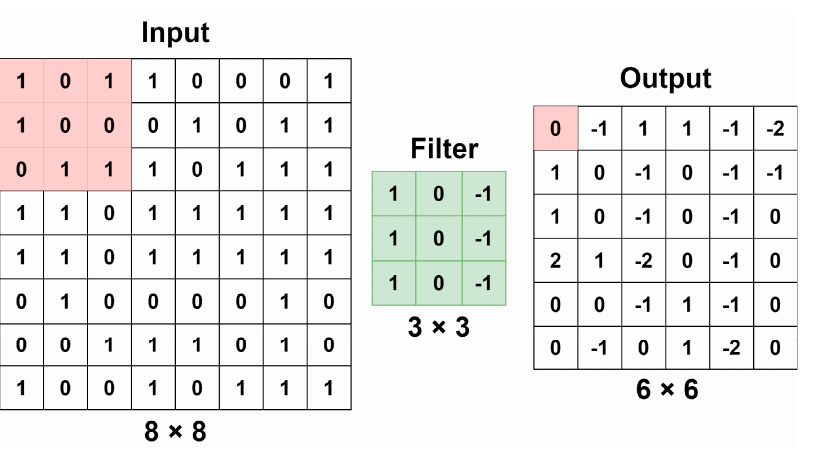
Figure 2. Convolution